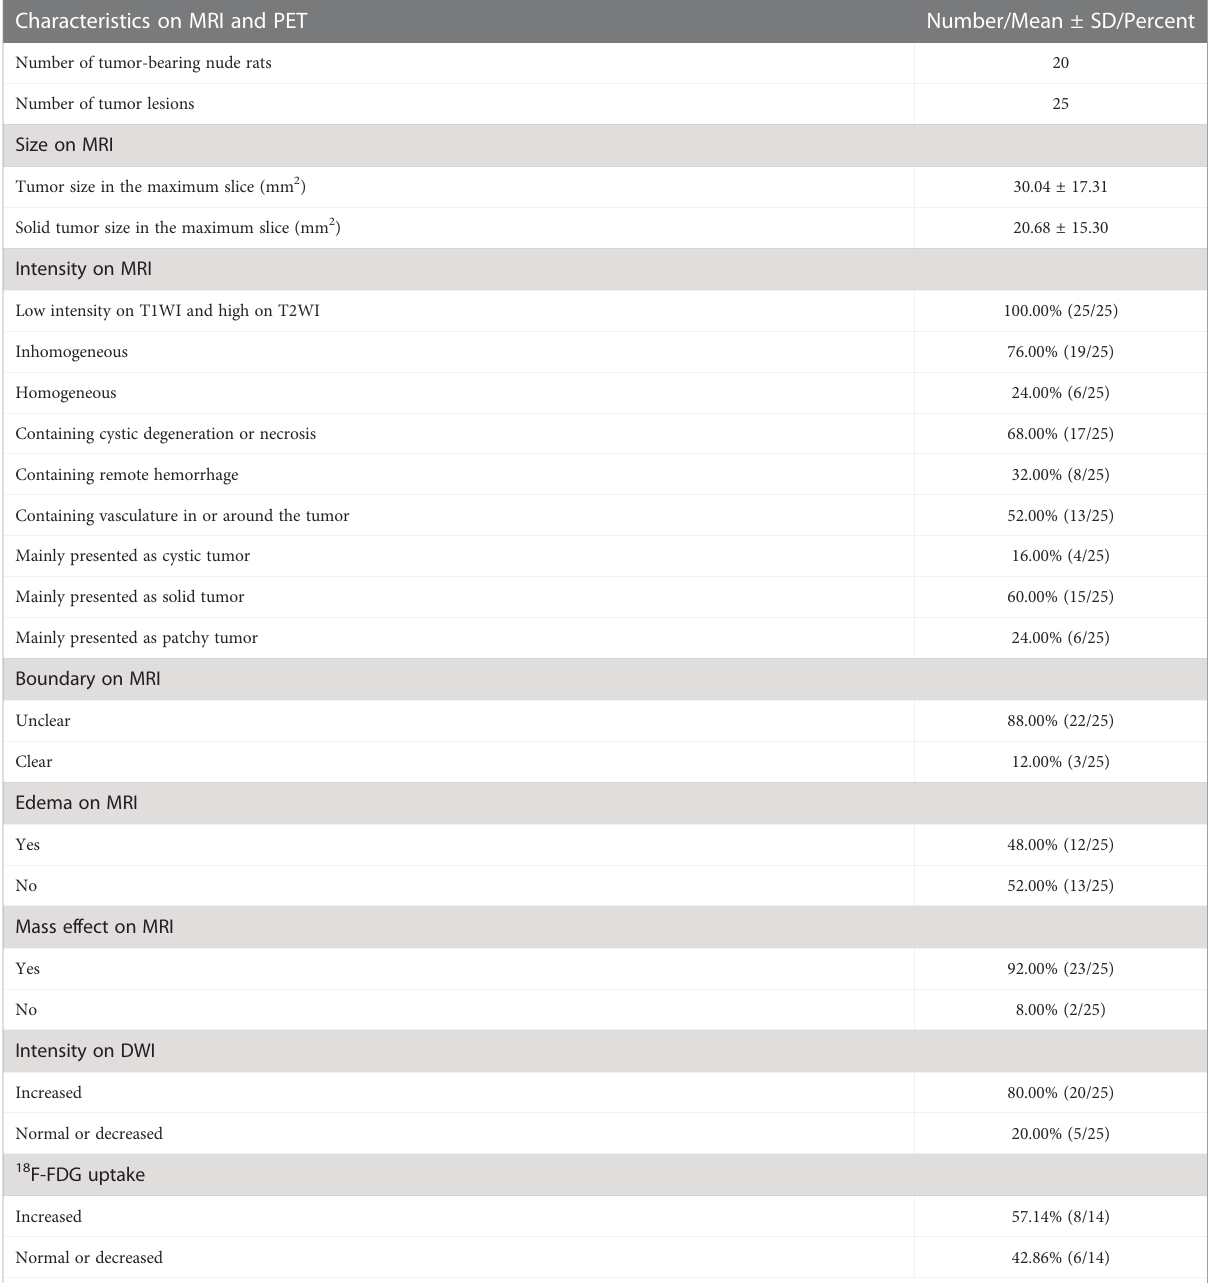
TABLE 1 Characteristics of tumor lesions on MRI and PET. Characteristics on MRI and